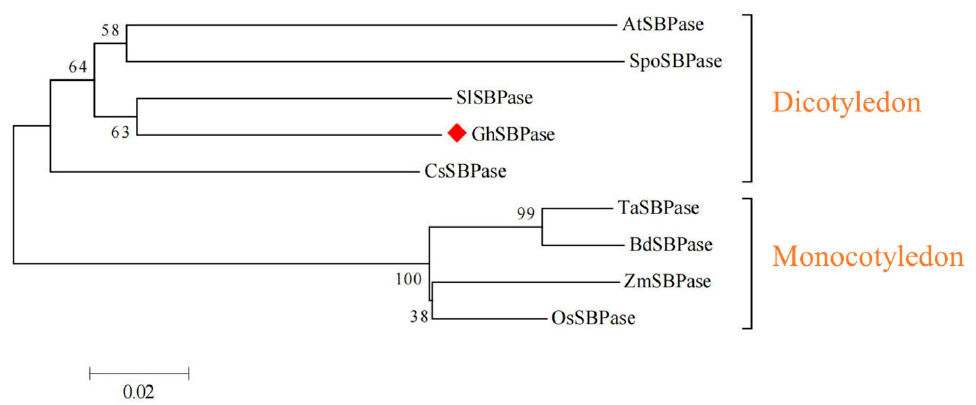
Figure 4. Phylogenetic tree analysis of SBPase protein from upland cotton and other plants. The numbers on the branches represent the reliability percent of bootstrap values based on 1000 replication; the symbol ◆ represents GhSBPase in upland cotton; Arabidopsis thaliana , AtSBPase (AEE79443); Oryza sativa , OsSBPase (AAO22558); Zea mays , ZmSBPase (ONM36378.1); Triticum aestivum , TaSBPase (CAA46507); Solanum lycopersicum , SlSBPase (FJ959073); Cucumis sativus , CsSBPase (ACQ82818); Spinacia oleracea , SpoSBPase (O20252.1), and Brachypodium distachyon , BdSBPase